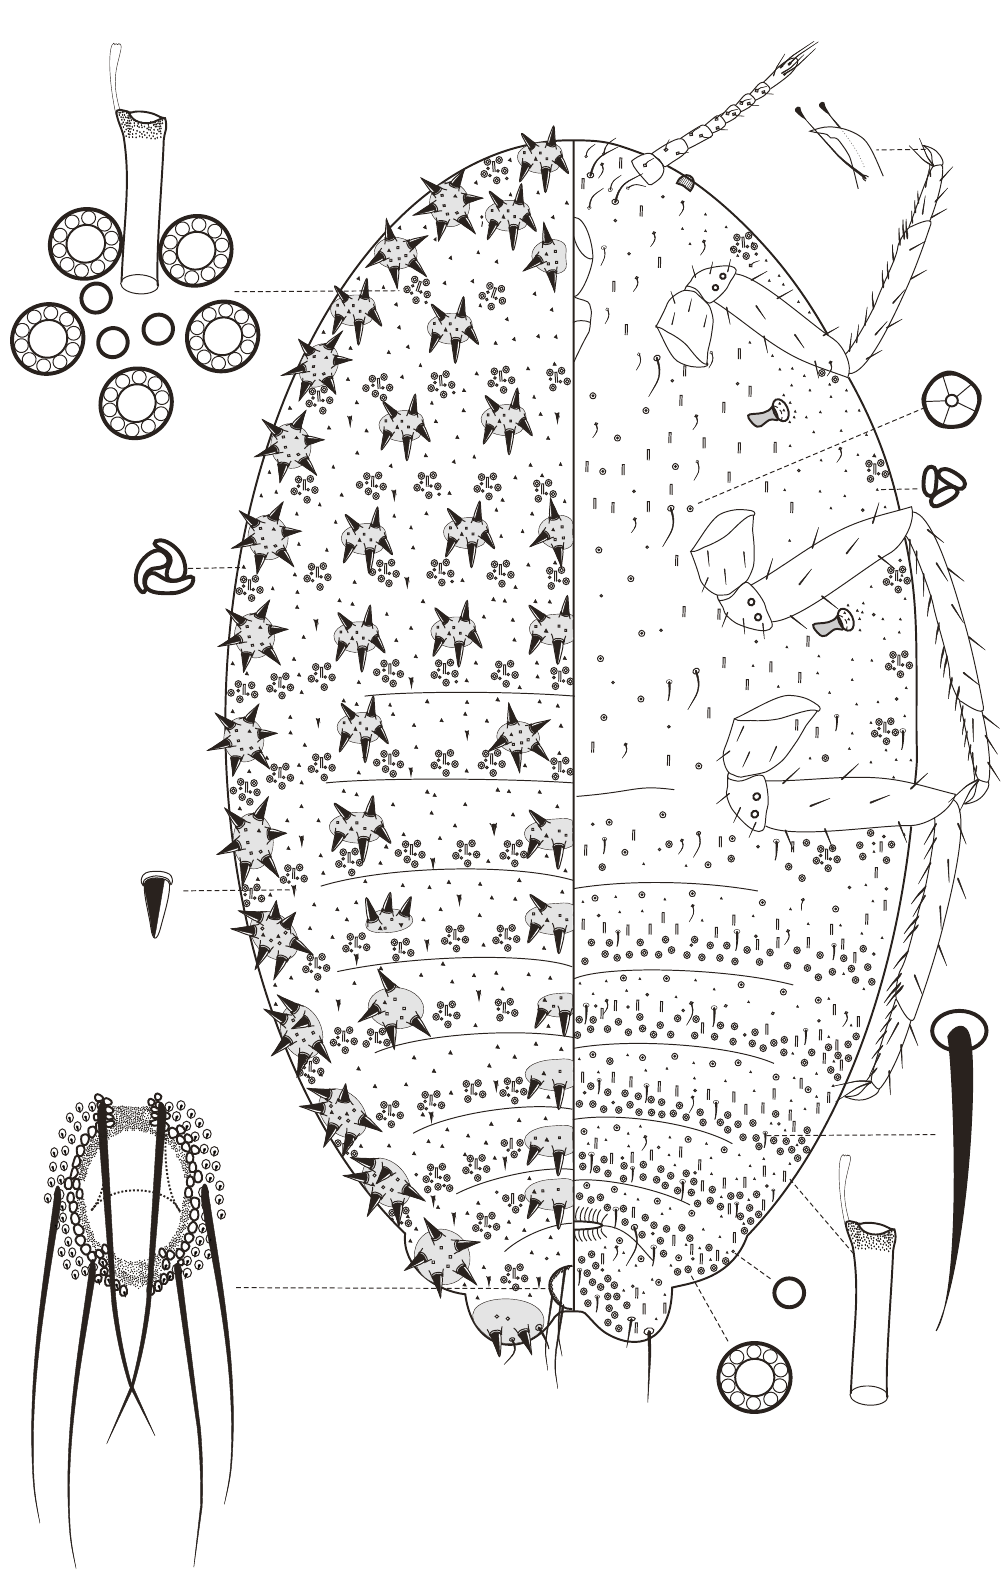
Fig. 2. Coccidohystrix daedalea Gavrilov-Zimin sp. nov., adult female,